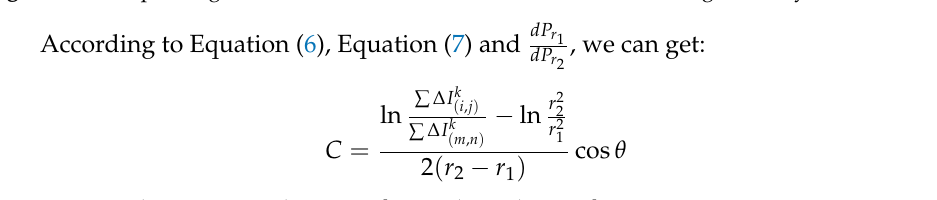
Figure 2. Principle diagram of the AFD method to find the backscattering intensity in the